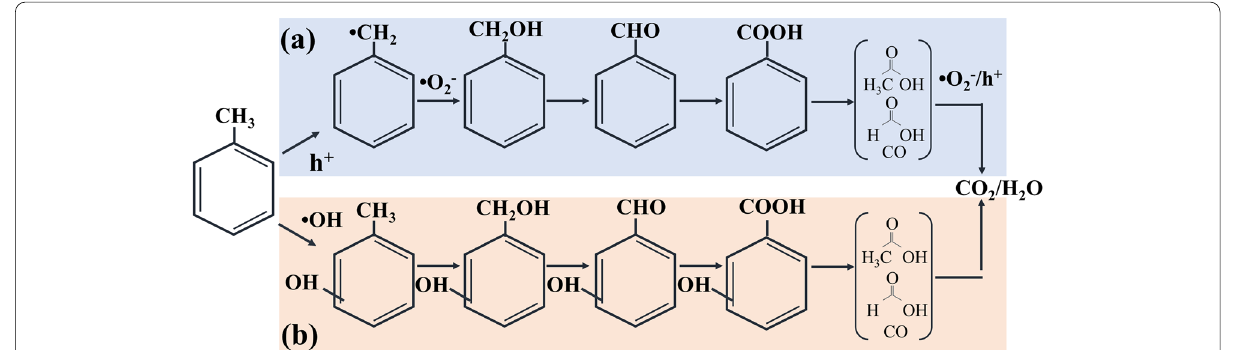
Fig. 10 Predicted photocatalytic degradation of toluene under (a) 0% RH or (b) 60%